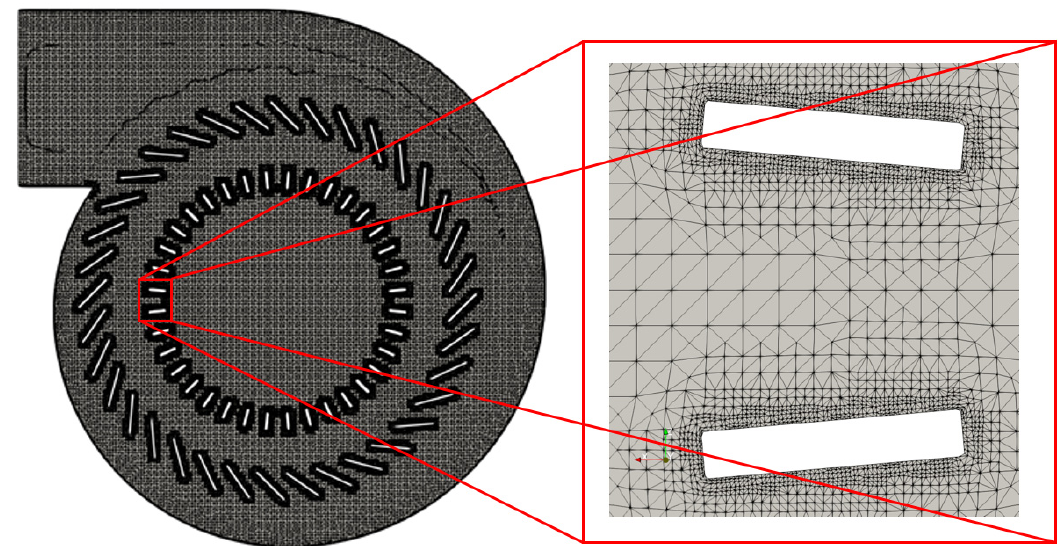
Figure 2. A horizontal slice of the mesh of the classifier.